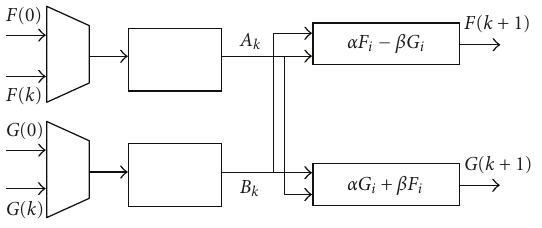
Figure 2: Arithmetic processor for the crossed paired